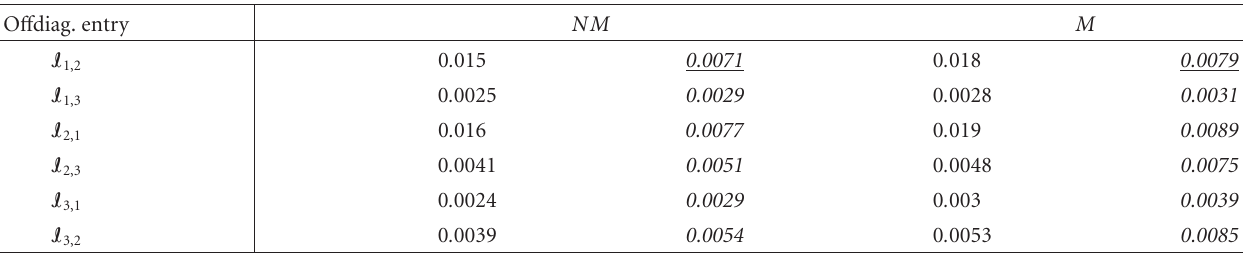
Table 4: Standard deviations of the o ff diagonal entries I ij defined by (22) obtained while separating realistic component maps by joint diagonalization of covariance matrices in wavelet space, with ( M ) and without masking ( NM ) part of the data. Components 1, 2, and 3, respectively, stand for CMB, dust, and SZ. The numbers in italic were obtained with Gaussian maps and the underlined numbers correspond to the histograms in Figure